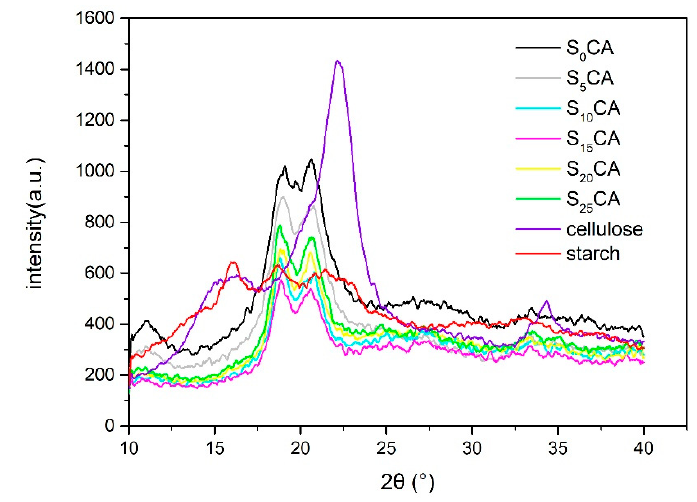
Figure 3. X-ray di ff ractogram (XRD) pattern of the aerogels with di ff erent starch content. Figure 3. X-ray diffractogram (XRD) pattern of the aerogels with different starch content.